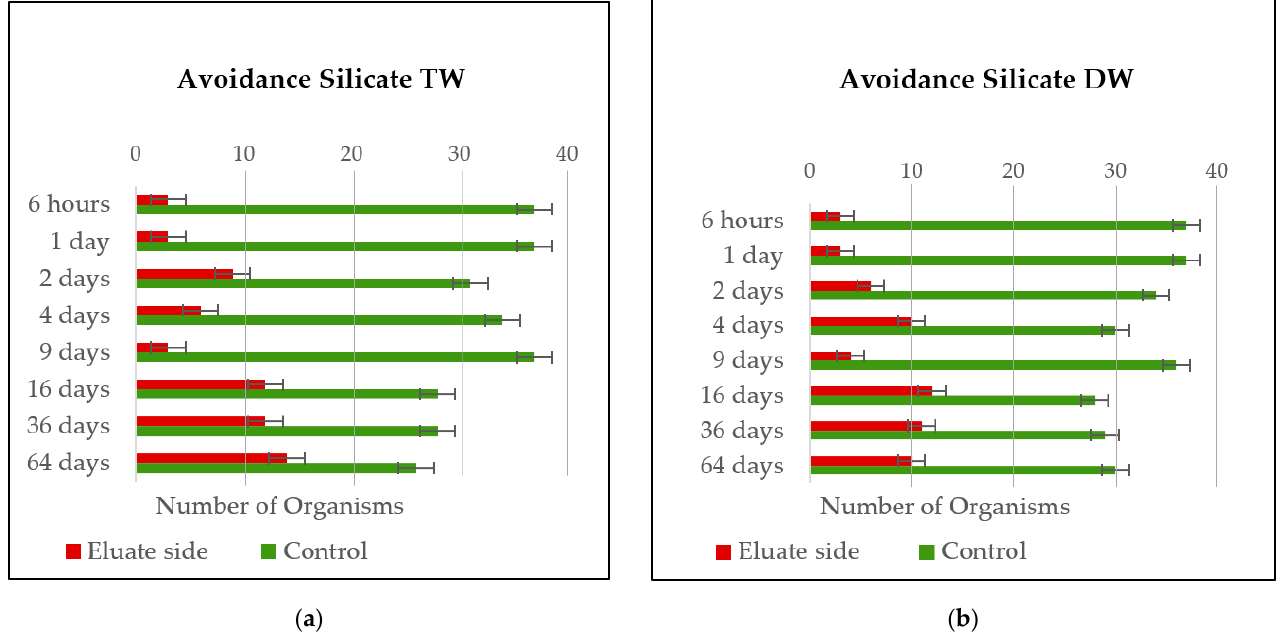
Figure 8. ( a ) Enchytraeid avoidance results for the silicate leach using tap water. ( b ) Enchytraeid avoidance results for the silicate leach using distilled water.